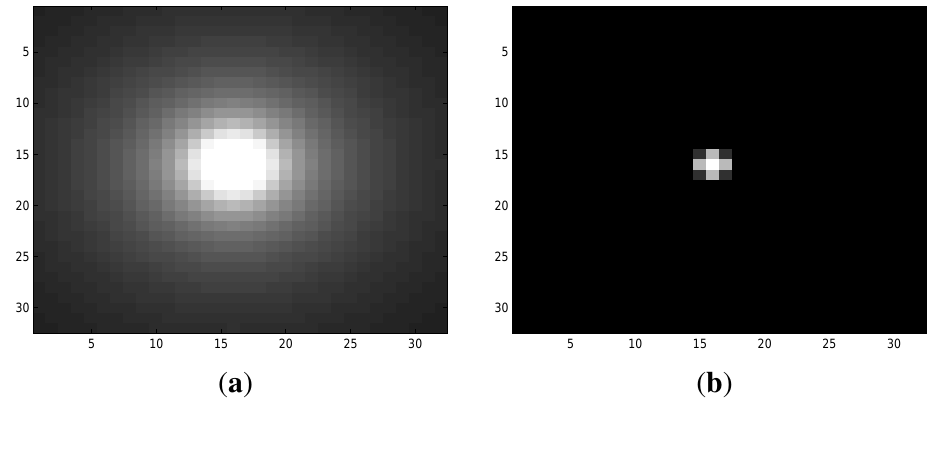
Figure 3. ( a ) Influence of an actuator in the center of a uniform 32 -by- 32 grid network of a collocated sensor and actuator system with a polynomially decaying influence region; ( b ) elements of the inverse matrix corresponding to the center actuator (gray-scale shades are used to represent the magnitude of each matrix element, with black denoting zero and white denoting the maximum